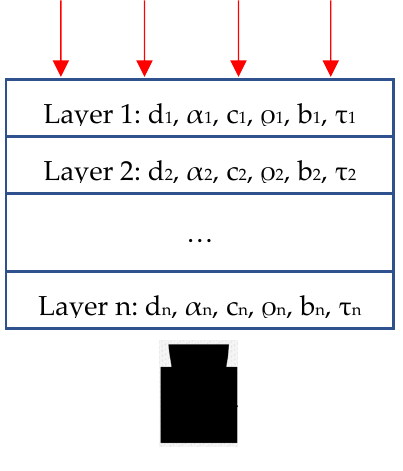
Figure 4. Multi-layer model.